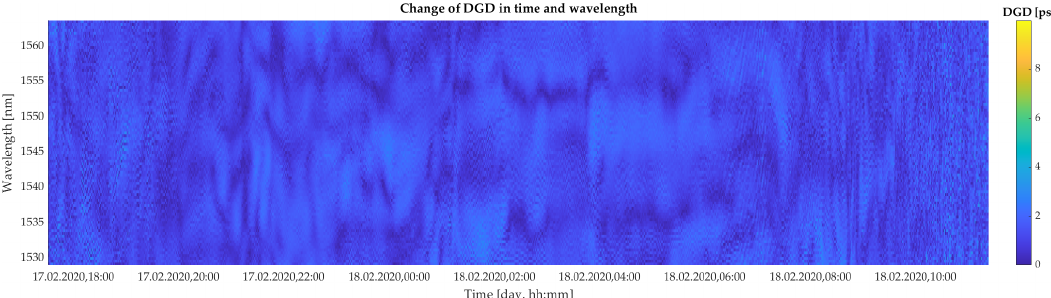
Figure 5. Colormap of the experimentally retrieved values of DGD as a function of 88 spectral channels in bandwidth ranging from 1528.97 nm to 1563 nm and selected time slots under a weak wind condition (wind speed up to 5 m/s).